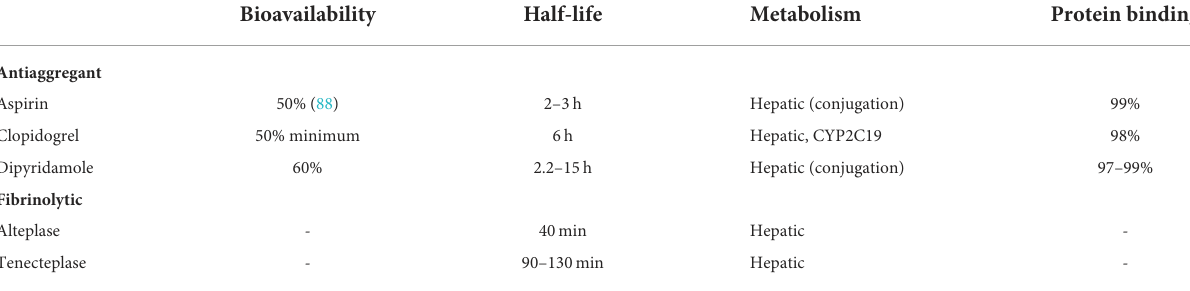
TABLE 4 Antiaggregant or fibrinolytic drugs (part I).